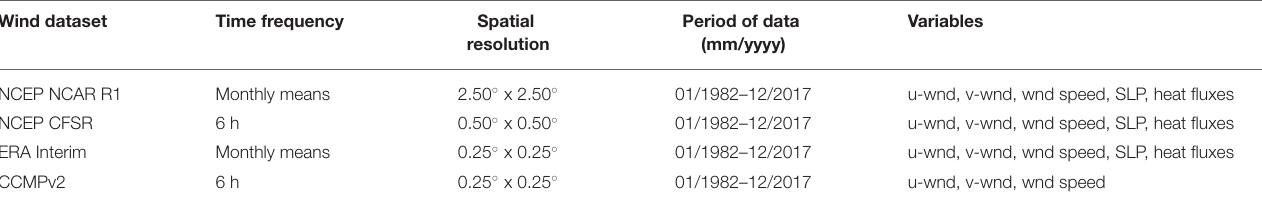
TABLE 1 | Wind datasets used in this work.